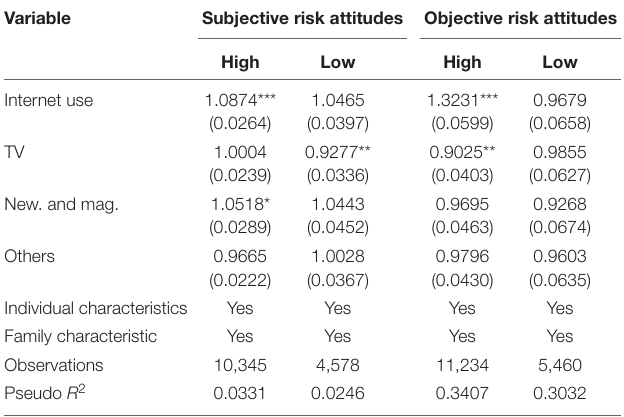
TABLE 3 | Grouped by the using frequency for studying.